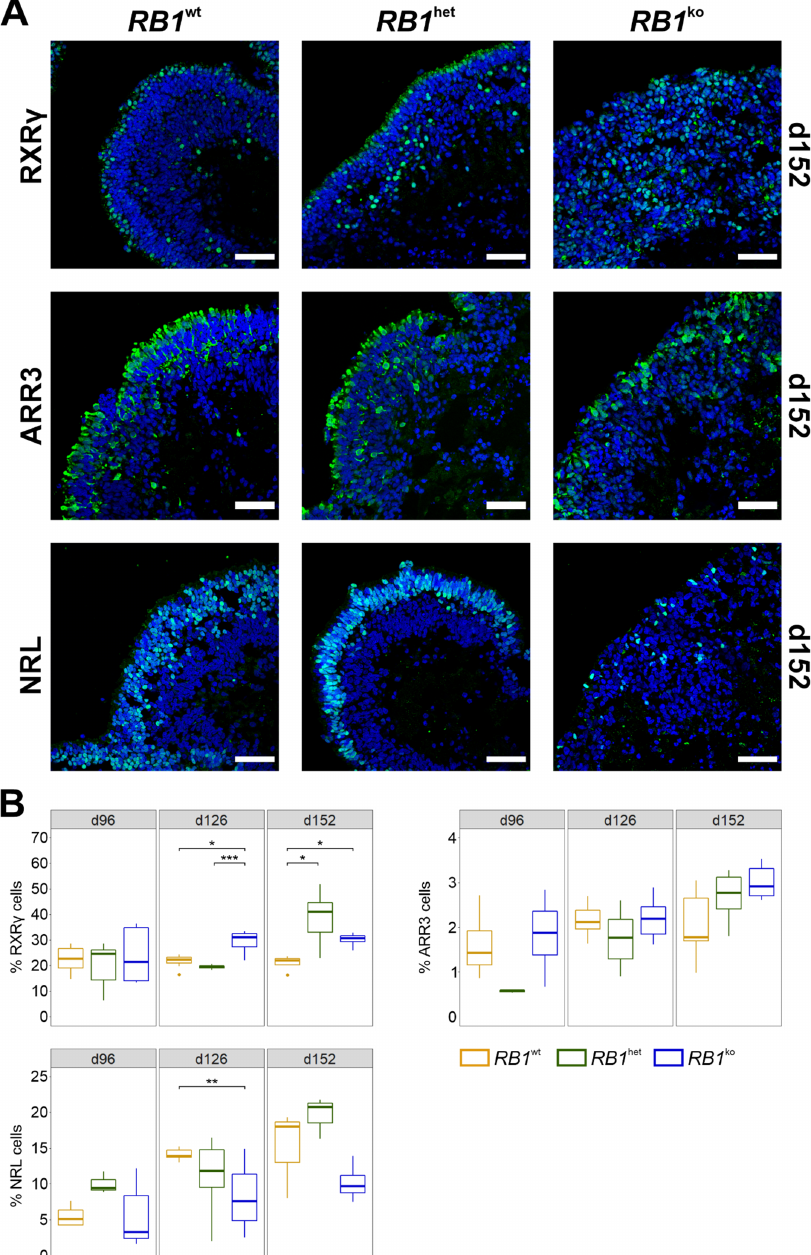
Figure 2. Cone and rod photoreceptors at d152. ( A ) Representative images of immunofluorescent staining of cells expressing RXR γ (immature cone marker), ARR3 (maturing cone marker), NRL (early rod marker). Marker proteins in green, nuclei counterstained with DAPI (blue). Scale bar 50 µ m. ( B ) Quantification of RXR γ - and ARR3-positive cone photoreceptors and NRL-positive rod photoreceptors based on microscopy images. Percentages of marker-positive cells per total DAPI-positive area are given. * p ≤ 0.05, ** p ≤ 0.01, *** p ≤